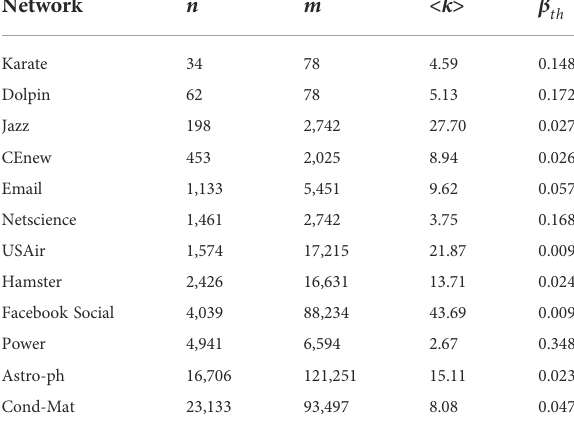
TABLE 4 Basic characteristics of the 12 complex network datasets, where < k > denotes the average degree of the network, and β th denotes the threshold of infected probability in the SIR